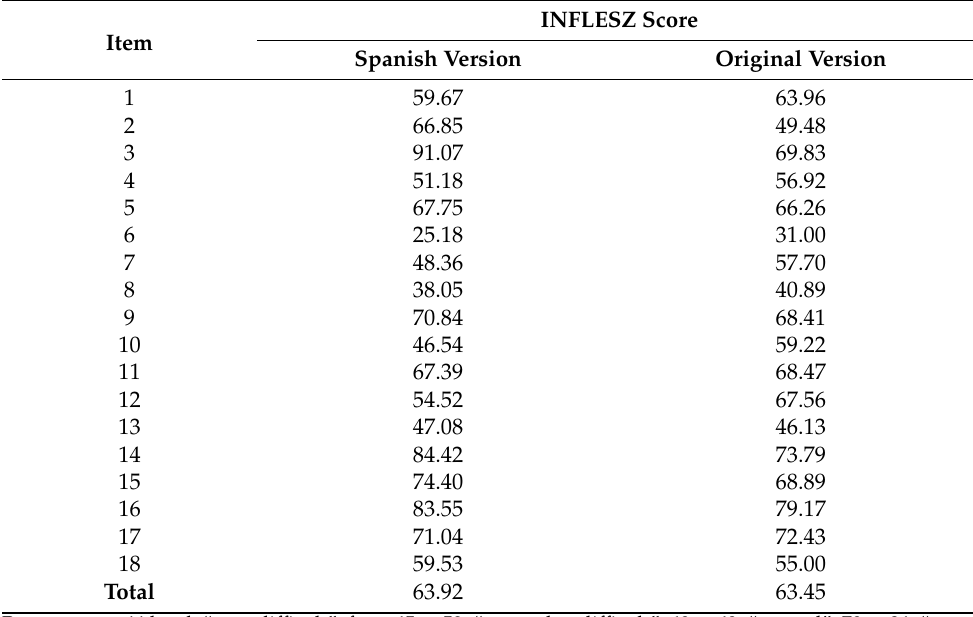
Table 1. FKQ readability in Spanish and original language from INFLESZ.